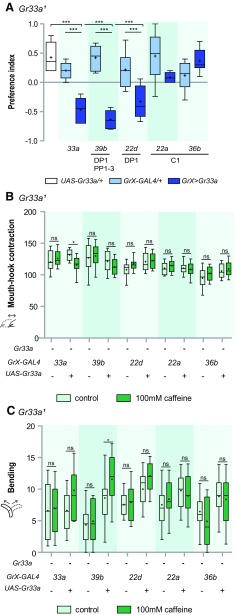
DP1 is sufficient for CAF-induced aversive responses in ingestion and choice preference. A, Choice preference in response to 100 mM CAF on expression of Gr33a in the Gr33a mutant using the indicated Gr-GAL4 drivers for specific expression in the GRNs listed under the underlines. For each data point, 6 < n < 12; ***p < 0.001 versus GAL4 and UAS control, one-way ANOVA followed by the Newman–Keuls method. B, Comparison of reduction of mouth-hook contractions in response to 100 mM CAF on expression of Gr33a in the Gr33a mutant using the indicated Gr-GAL4 drivers for specific expression in the GRNs. For each data point, 18 < n < 28; *p < 0.05, two-way ANOVA followed by the Bonferroni post hoc test. ns, not significant. C, Comparison of increase in bending in response to 100 mM CAF on expression of Gr33a in the Gr33a mutant using the indicated Gr-GAL4 drivers for specific expression in the GRNs. For each data point, 18 < n < 28; *p < 0.05, two-way ANOVA followed by the Bonferroni post hoc test. ns, not significant. + and – indicate whether transgenes are present or absent.